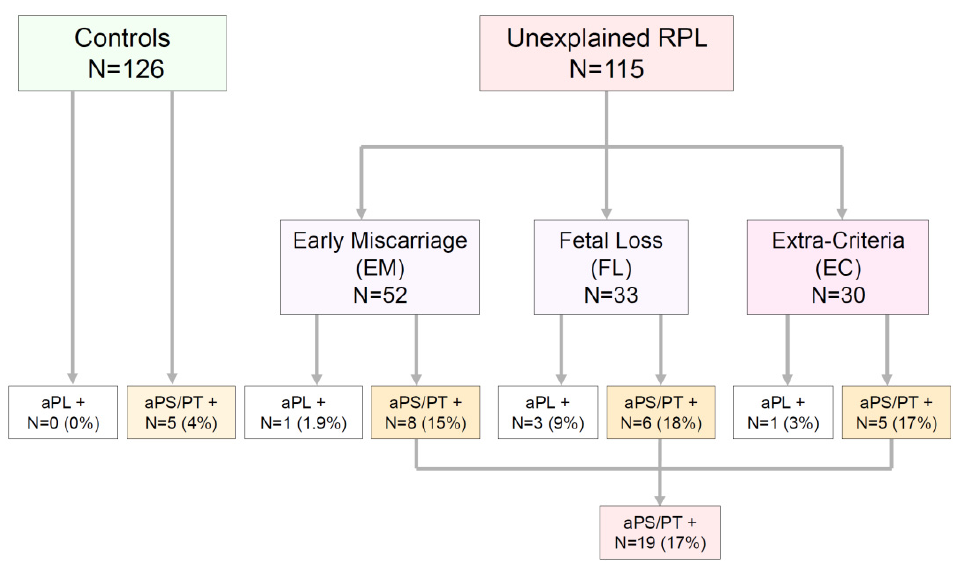
Figure 1. Positivities of criteria aPL (aPL) and aPS/PT among groups of patients and controls are shown. While positivity of criteria aPL did not surpass 10% in each one of the groups, aPS/PT was positive in 15–18% of patients.